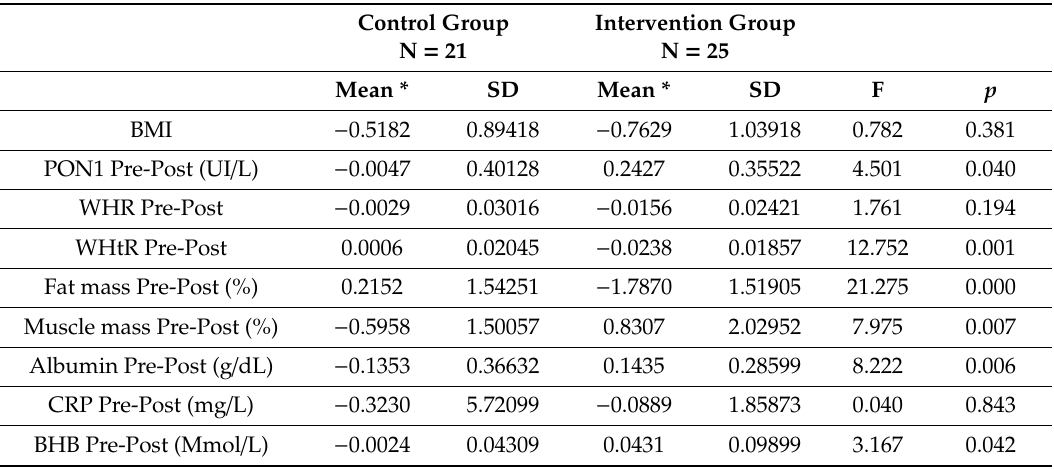
Table 3. Comparison of change scores after completion of intervention versus